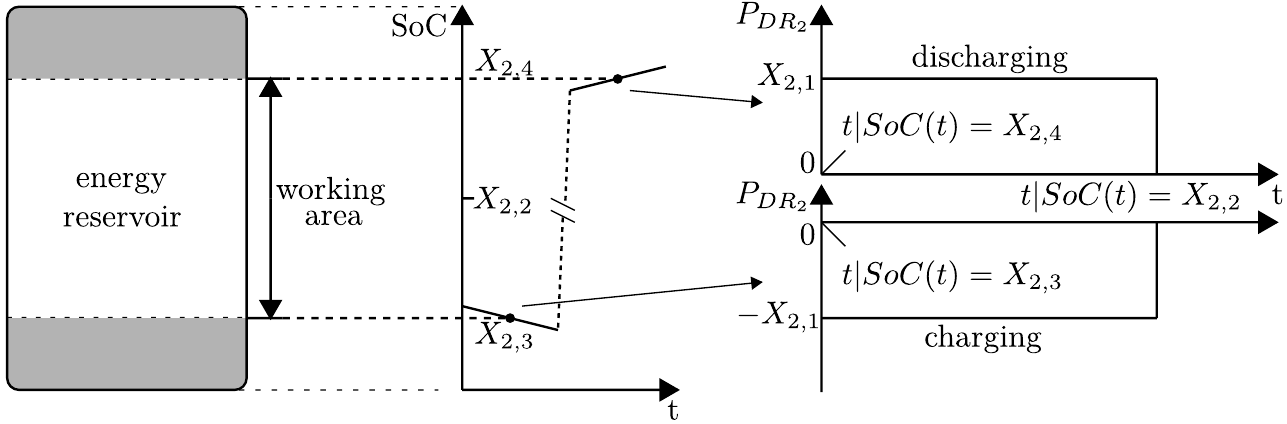
Figure A1. Behavior of